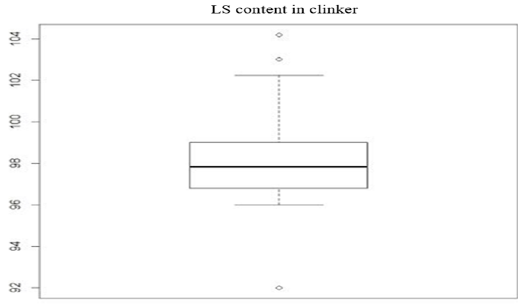
Figure 7. LS content in clinker. Source: own source.